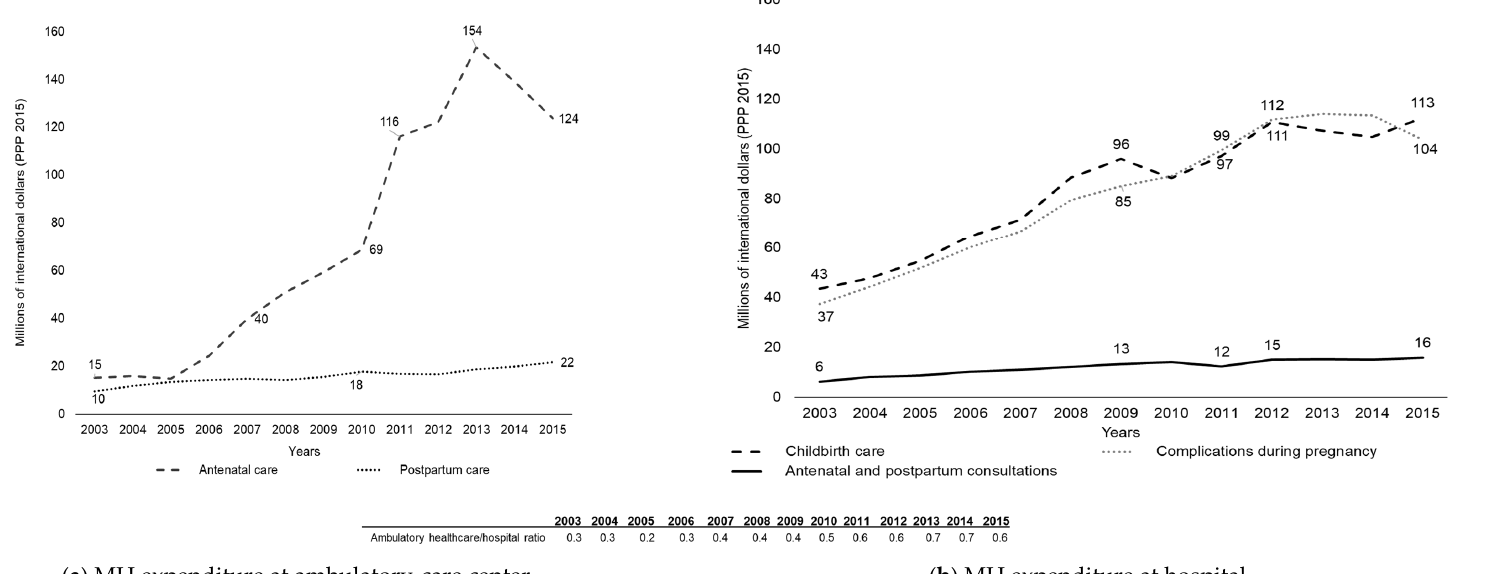
Figure 2. Government Maternal Health (MH) expenditure for adolescent women aged 10–19, without Social Security coverage, by type of healthcare